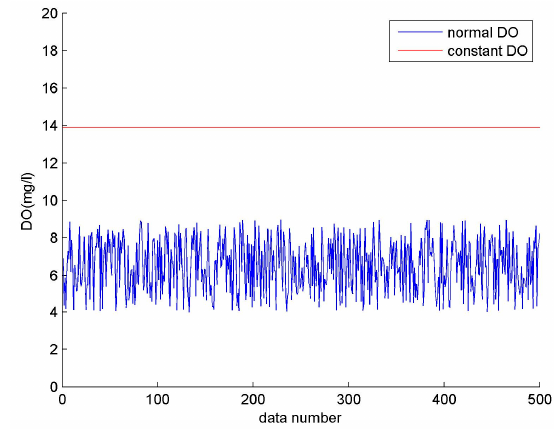
Figure 3. Constant output (DO).